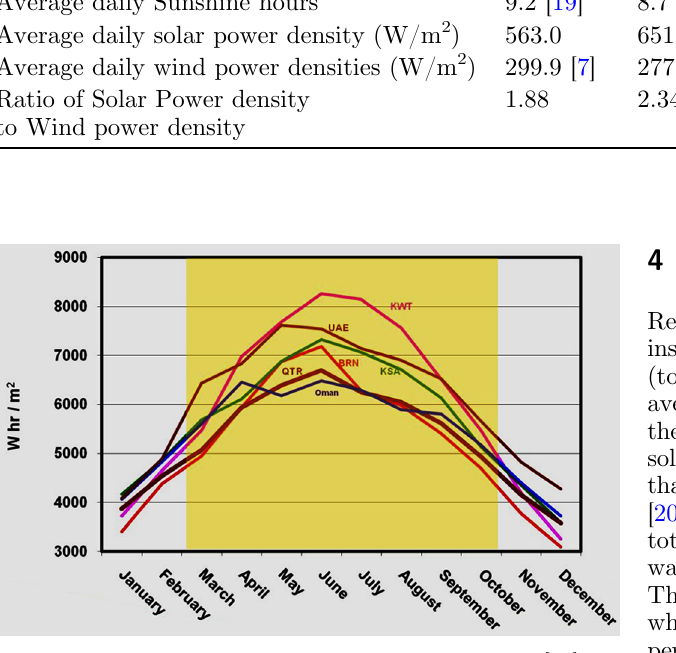
Fig. 8. The daily average solar radiation in GCCC